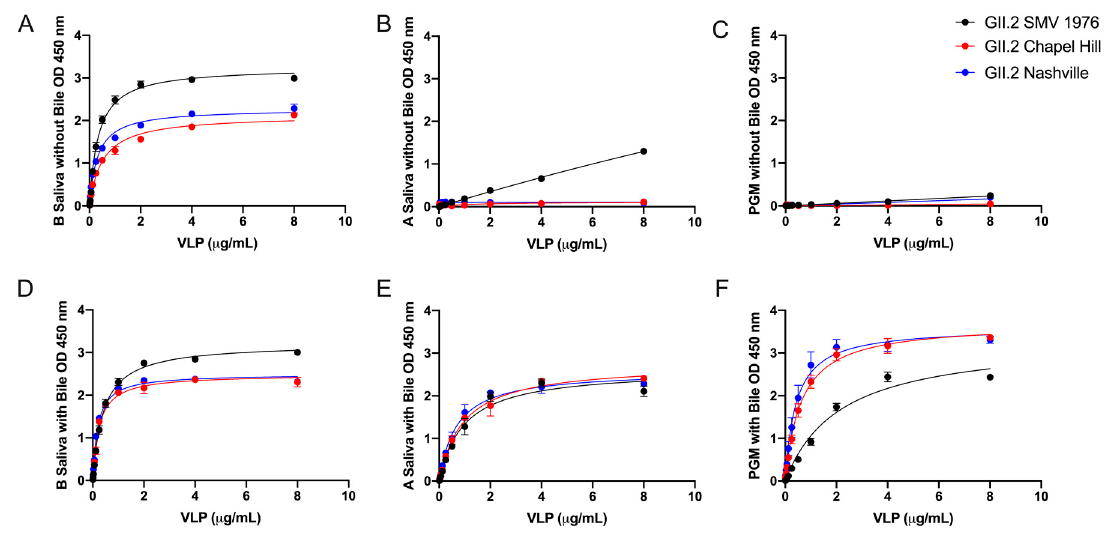
Figure 3. Bile enhances the binding of GII.2 VLP to ligands present in PGM and human type A saliva. VLP were titrated starting against human type B Saliva ( A , D ), A Saliva ( B , E ), and PGM ( C,F ) with ( D – F ) and without ( A – C ) 1% bile. OD were fit using one-site specific binding curves, with error bars representing standard error of the mean.